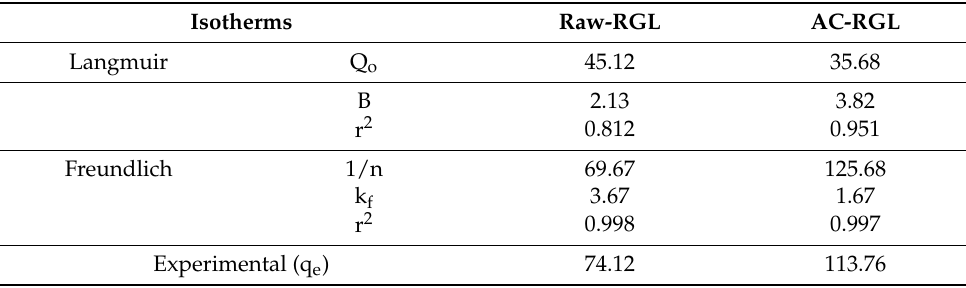
Table 4. Adsorption isotherms of Raw-RGL and AC-RGL and parameters.